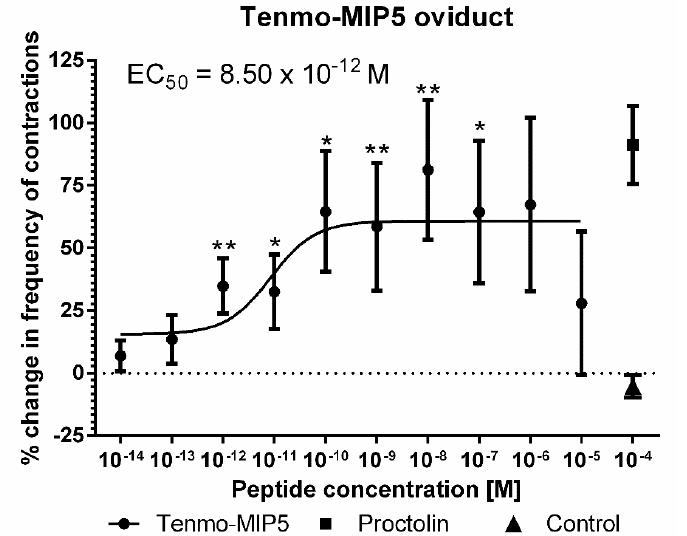
Figure 7. Changes in the oviduct contractile activity of T. molitor after the application of Tenmo-MIP 5 compared to the control. Means ± SEM are given for n ≥ 15. Significant di ff erences from the control (saline application) are indicated by * p ≤ 0.05, ** p ≤ 0.01, (one-way ANOVA). Proctolin, a potent myostimulator, was used as a positive